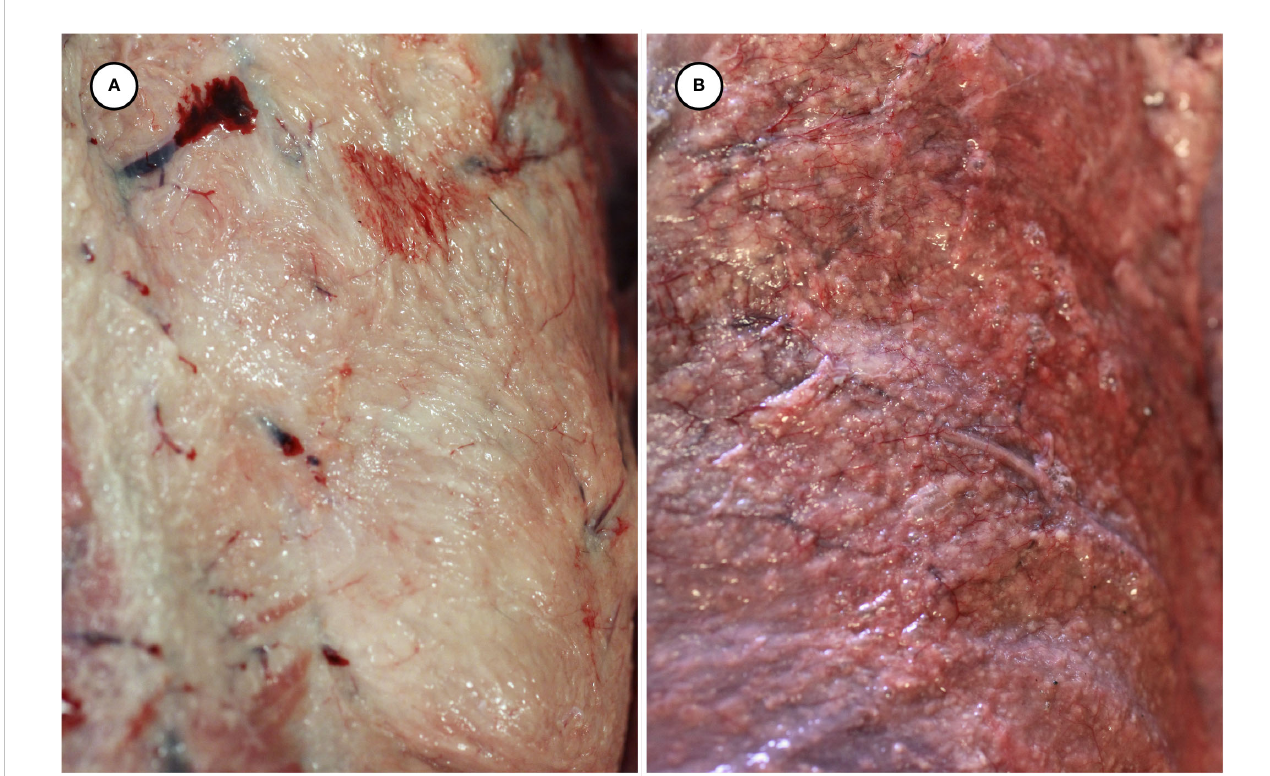
FIGURE 1 Gross appearance of normal subcutaneous adipose from an unaffected sea otter (A) , compared with congested and multinodular-appearing adipose from a sea otter with fatal protozoal steatitis and toxoplasmosis (B)